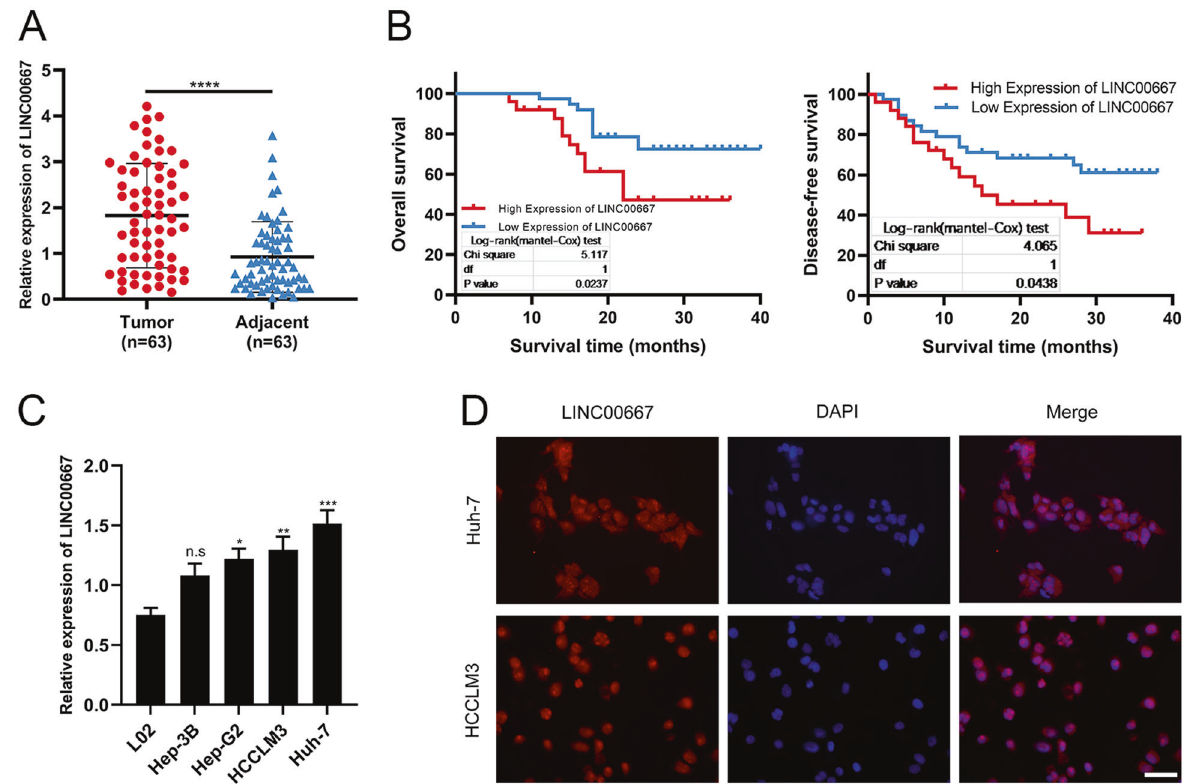
Fig. 1 LINC00667 is overexpressed in HCC tissues and contributes to poor prognosis. A Overexpression of LINC00667 was detected in HCC tissues via RT-qPCR assay ( n = 63, paired t test). B Kaplan-Meier DFS and OS analysis of HCC patients with downregulated and upregulated expression of LINC00667. C The relative expression of LINC00667 in HCC and normal L02 cell lines were detected by RT-qPCR. Data ( n = 3) were analyzed by student ’ s t test. D Localization of LINC00667 in the cytoplasm and nucleus was detected by FISH assay. Blue color denotes DAPI-stained nuclei; red color denotes LINC00667; scale bar, 50 μ m; magni fi cation, 400×. Data, mean ± S.D.; ns, no signi fi cance. *, **, *** and **** = P < 0.05, < 0.01, < 0.001 and < 0.0001,